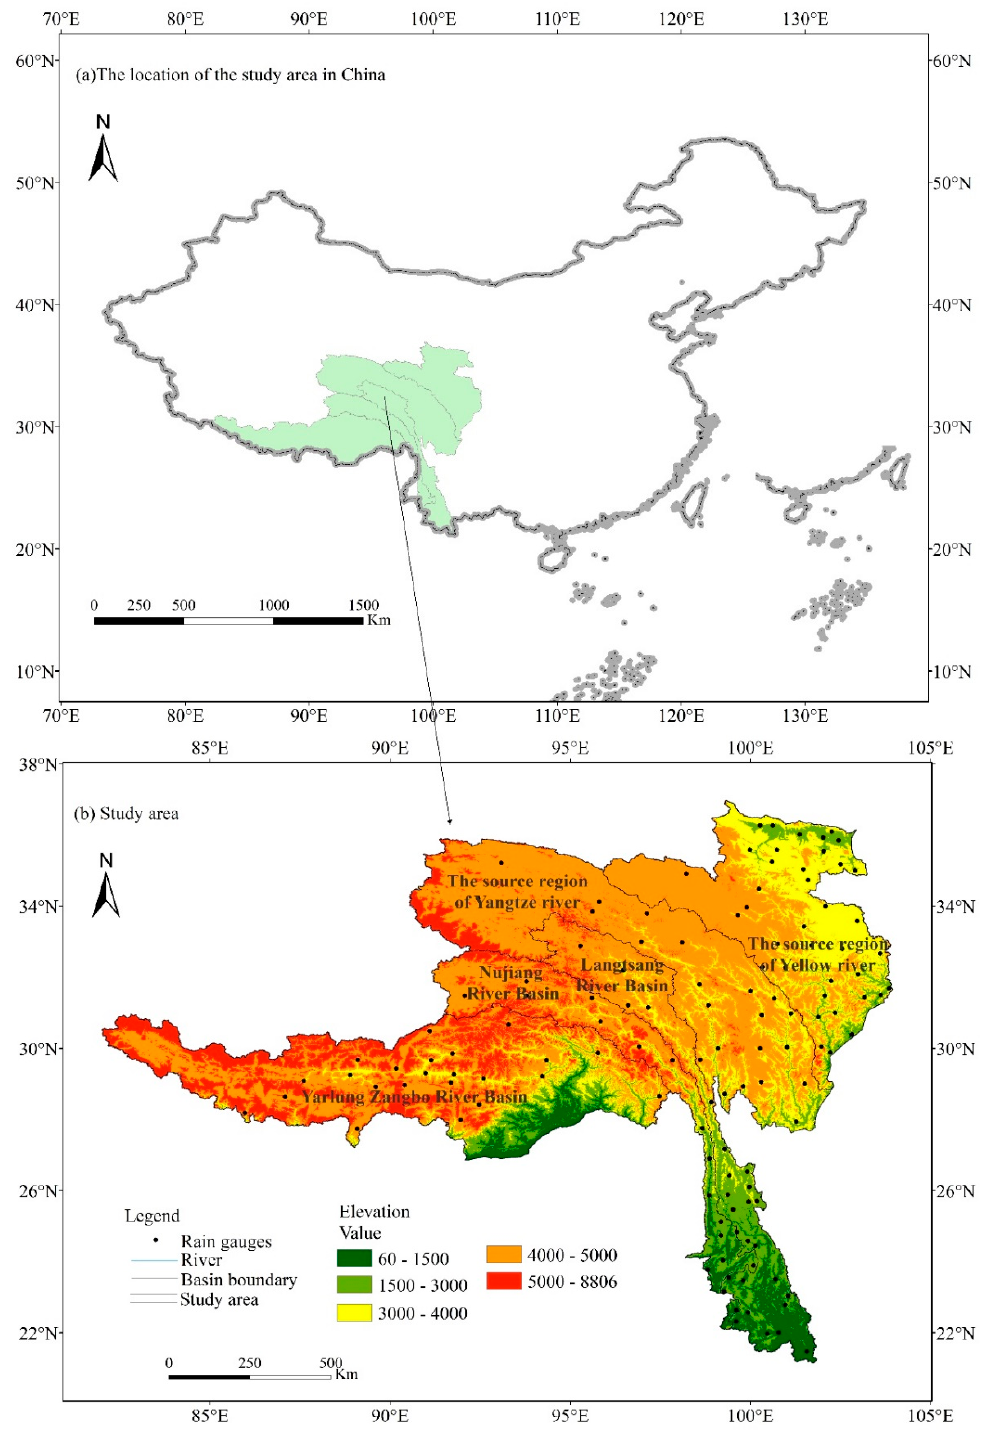
Figure 1. Overview of the study area (Figure ( a ) mainly expresses the geographic location of the study area in China; Figure ( b ) shows the detail information of the study area).